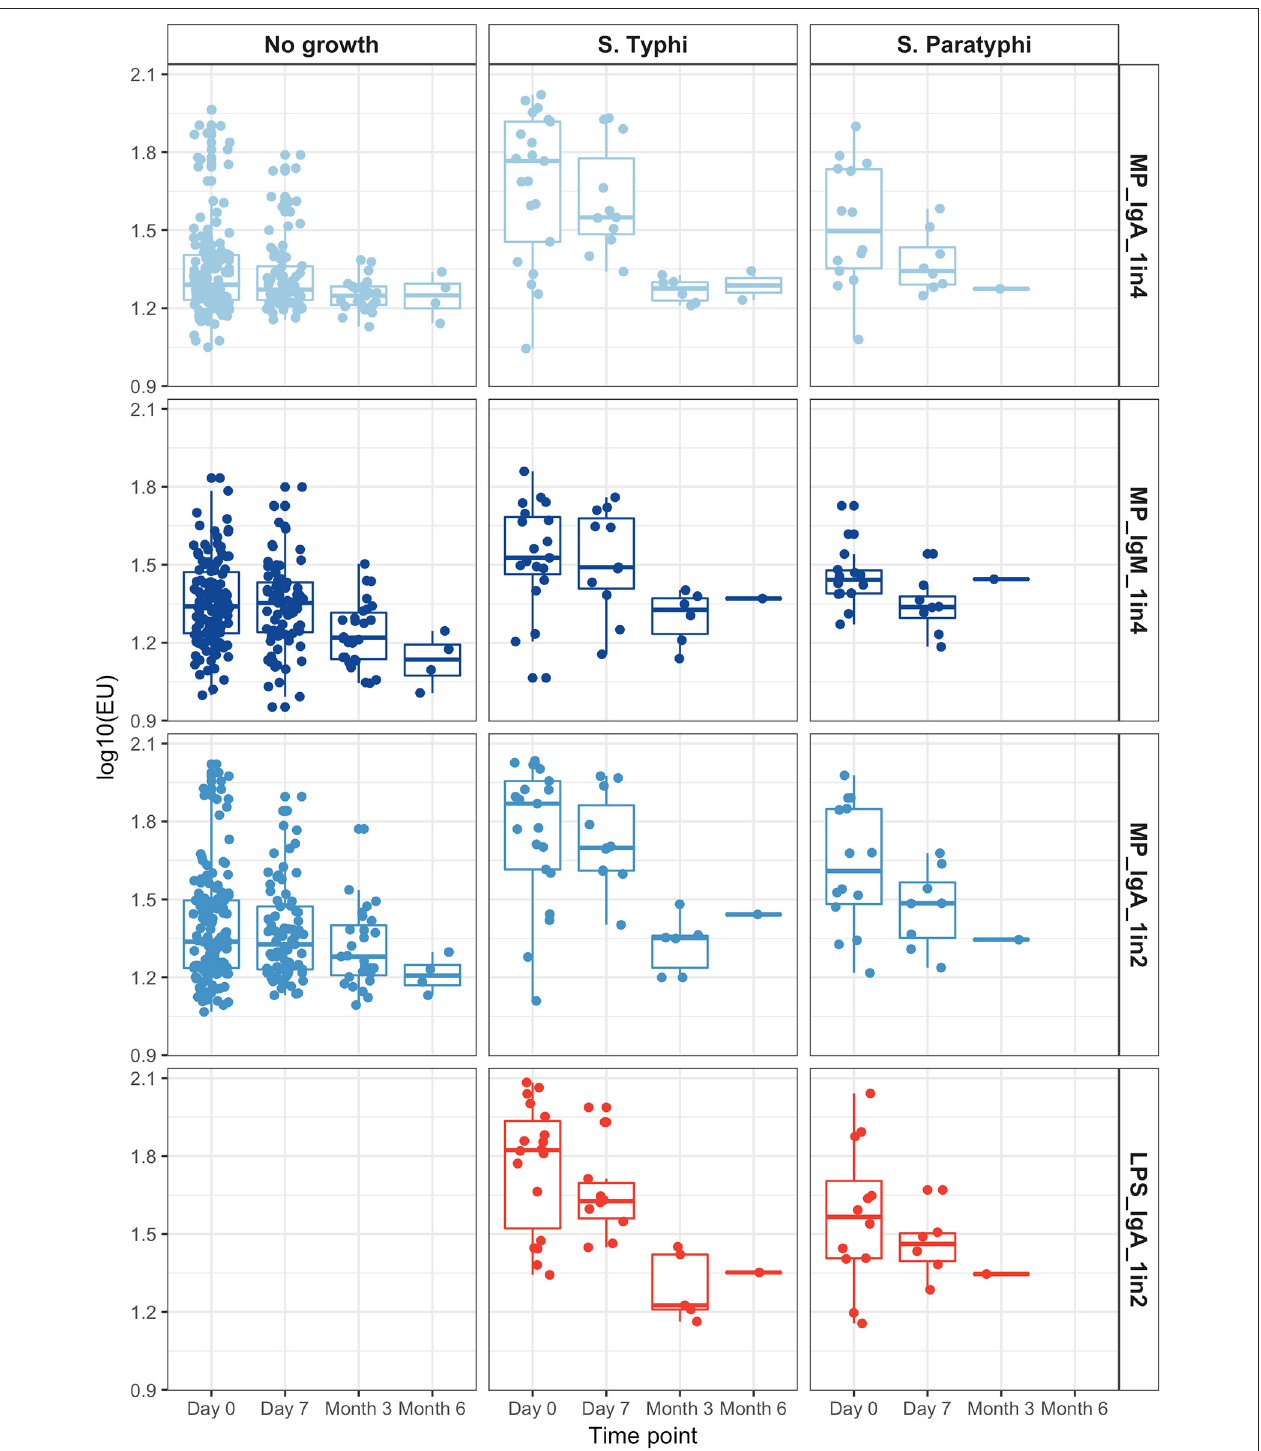
FIGURE 4 | Group ALS responses in each assay condition by time point, according to blood culture result.